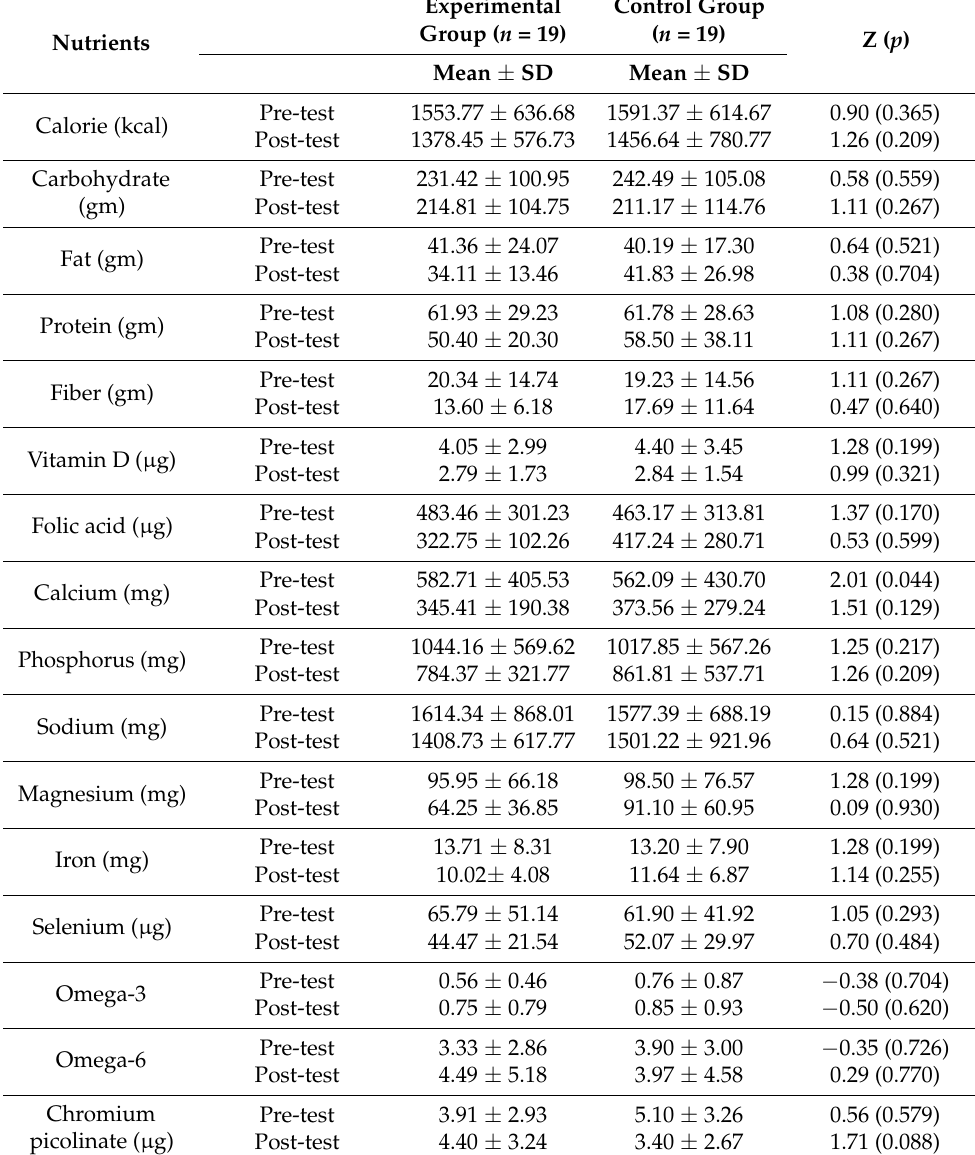
Table 5. Comparison of nutrients in the experimental and control groups ( n =